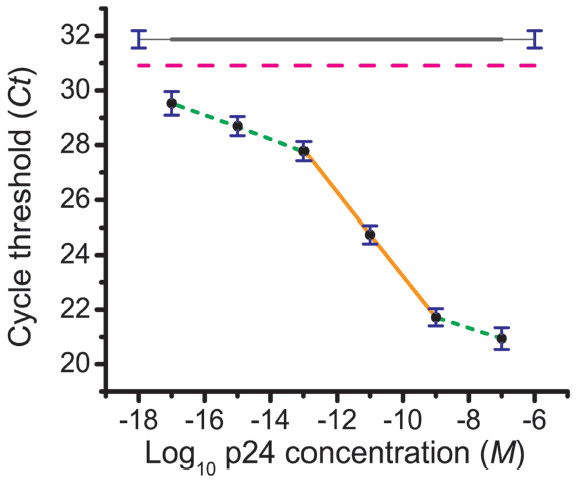
Quantitative ILPCR dose–response curve for p24 added to PBS buffer. A 100-μl sample volume (antigen diluted in PBS) was used for all concentrations. The black circles are the average of three replicate Ct measurements over a concentration range of 10-7 to 10-17 M p24; the standard deviations of the Ct values are shown as blue vertical bars. In order to be visible, the standard deviations were multiplied by the following values: 10-7 M (3x), 10-9 M (1x), 10-11 M (5x), 10-13 M (5x), 10-15 M (7x), and 10-17 M (1x). The remaining symbols and colors have the same designations as given in Figure 4.